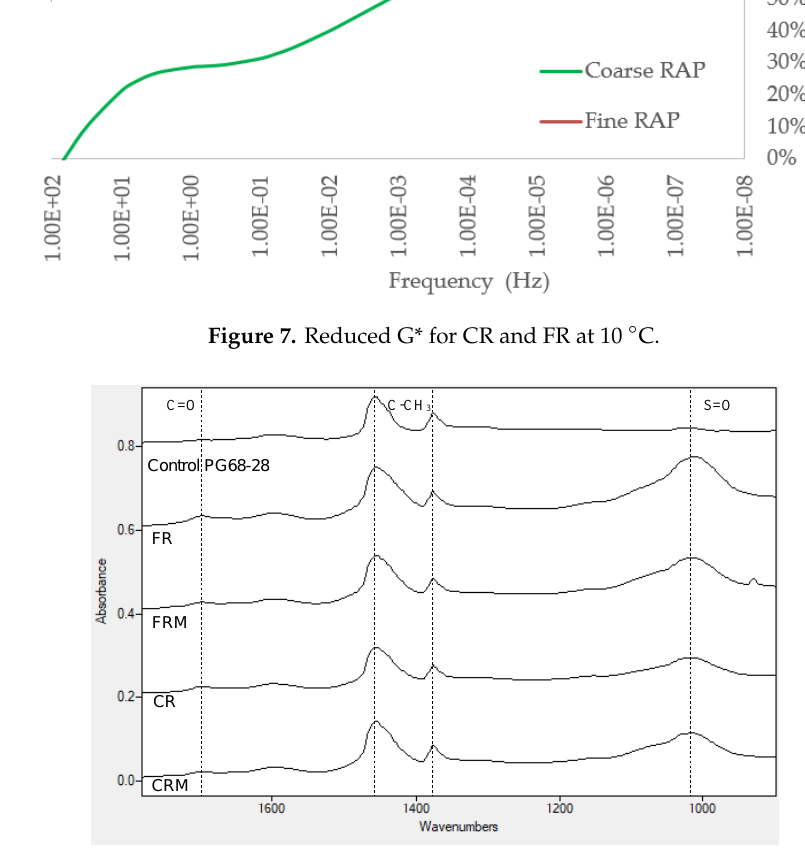
Figure 7. Reduced G* for CR and FR at 10 °C.